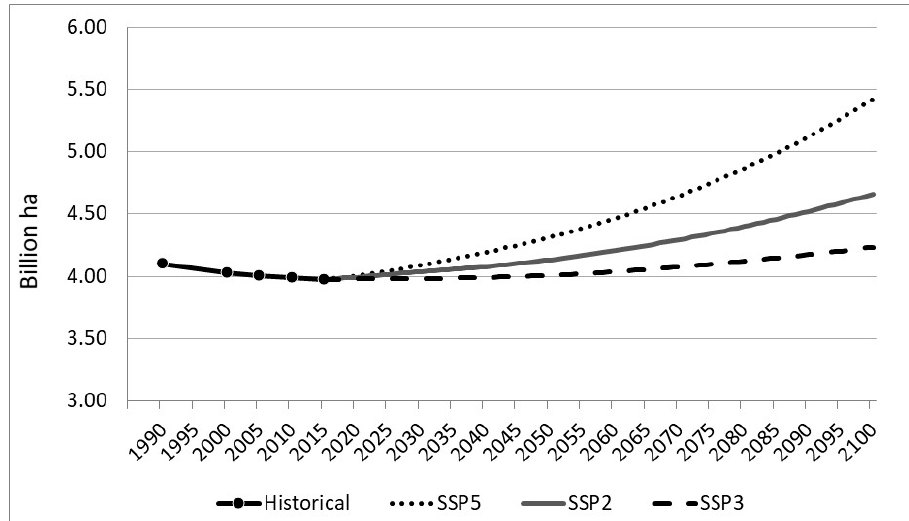
Figure 1. Projected global total forest area (billion ha) under different shared socioeconomic pathways (SSPs), 2015–2100. Projected explanatory variables driving total forest area projection include per capita income, its squared term, labor per unit forest area, and rural population density. The results represent the sum of projections for 168 countries including 48 countries in Africa, 46 in Asia, 36 in Europe, 17 in North America, nine in Oceania, and 12 in South America.